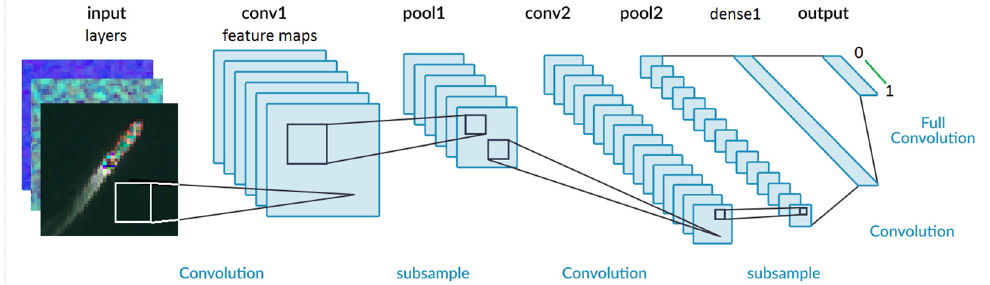
Figure 6. Sketch of a simple convolutional neural network with 3 input layers (RGB), two 2D convolutional layers followed by two pooling layers, one final dense layer. The output is a probability ranging from 0 (ship) to 1 (iceberg). Table 1. CNN1 layers and hyperparameters. Input channels are HH + HV for SAR and RGB for MSI datasets, where R includes both the red and near-infrared high-resolution bands. Image Layer Channels Size